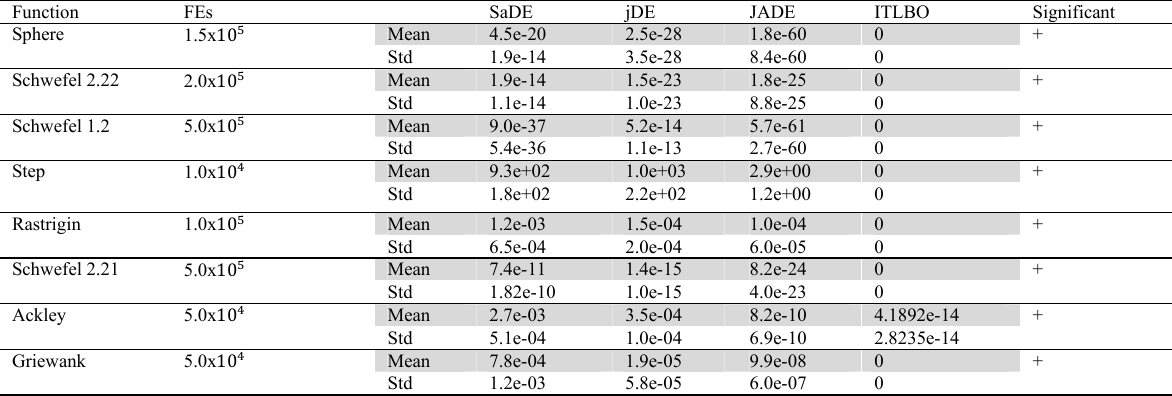
Performance comparisons ITLBO, IADE, jDE and SaDE Function FEs SaDE jDE JADE